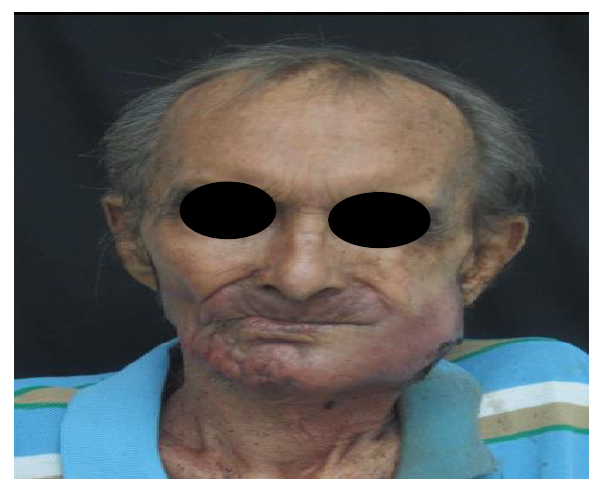
Fig. 1. Extraoral photo of the patient.